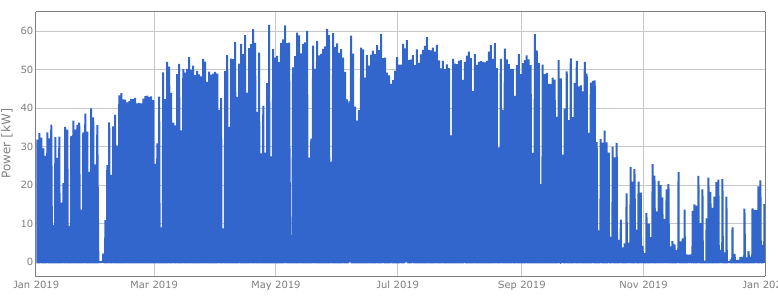
Figure 3. Power transit in the MV/LV transformer of Chiou.